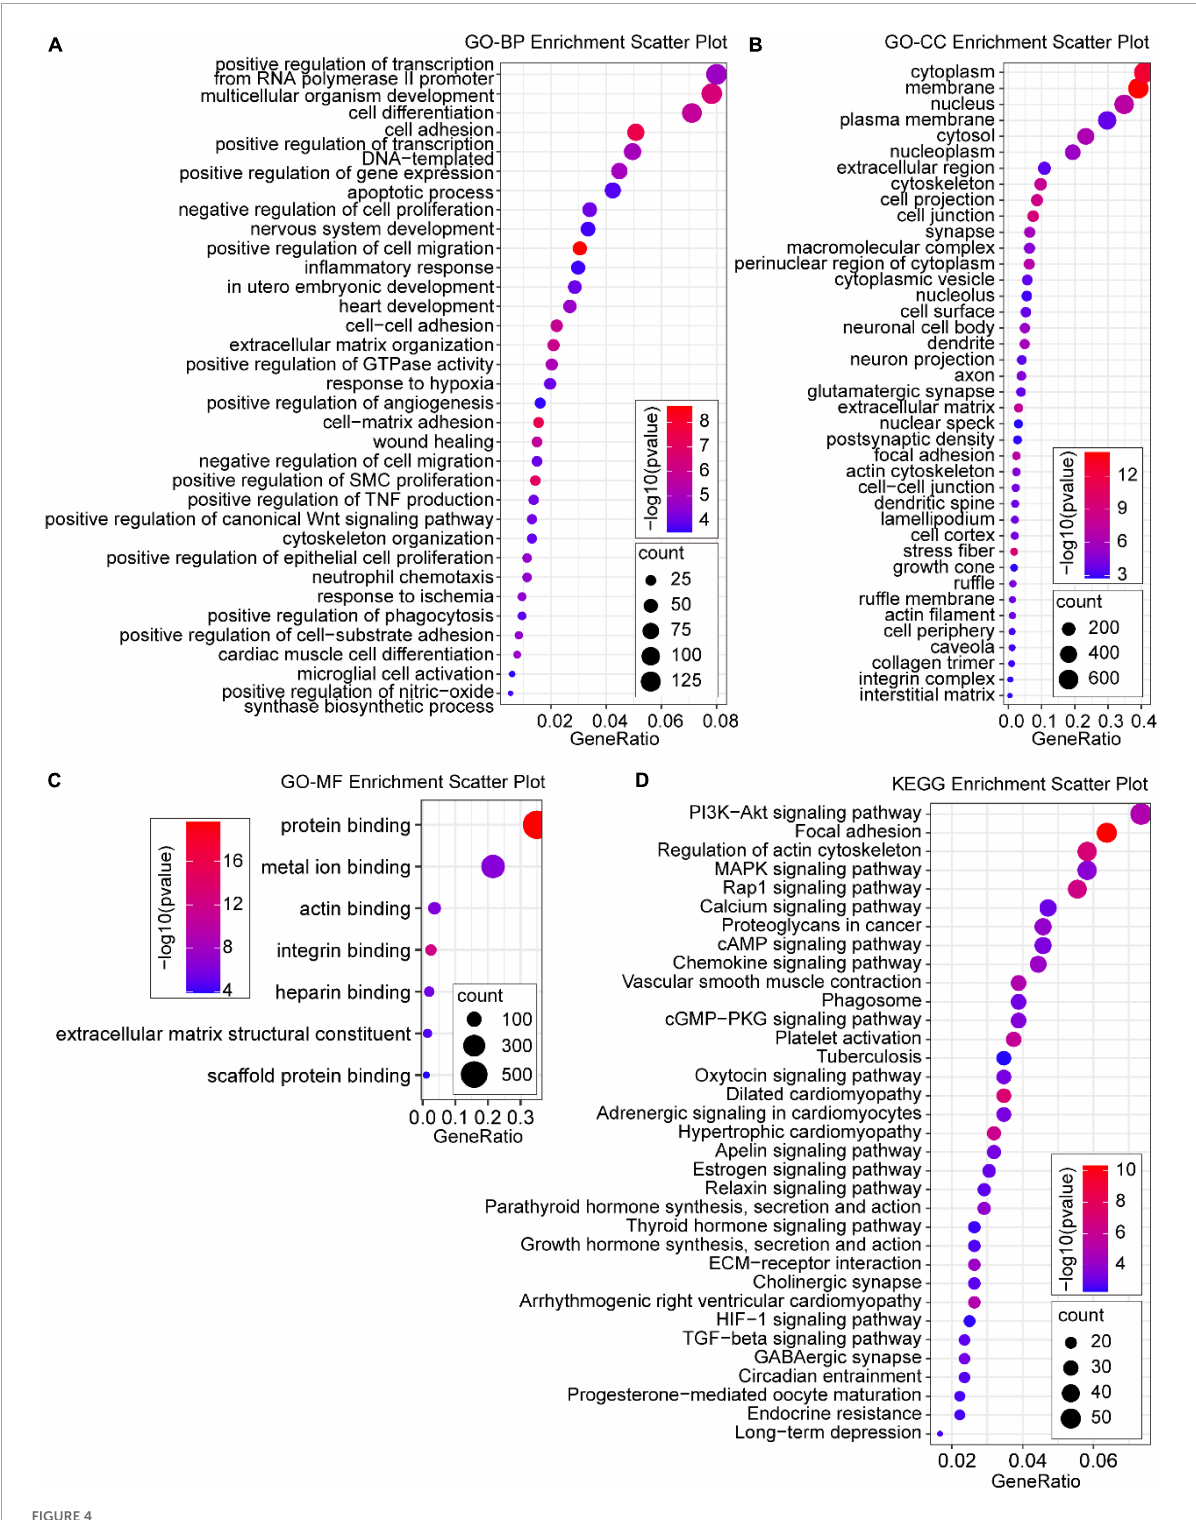
FIGURE4 Gene ontology (GO) and Kyoto Encyclopedia of Genes and Genome (KEGG) enrichment analysis of DE mRNAs. (A) Significant GO biological process (BP) terms; (B) significant GO cellular component (CC) terms; (C) most significant GO molecular function (MF) terms; (D) enriched KEGG pathway terms. P < 0.05 for all significant GO terms and KEGG pathway